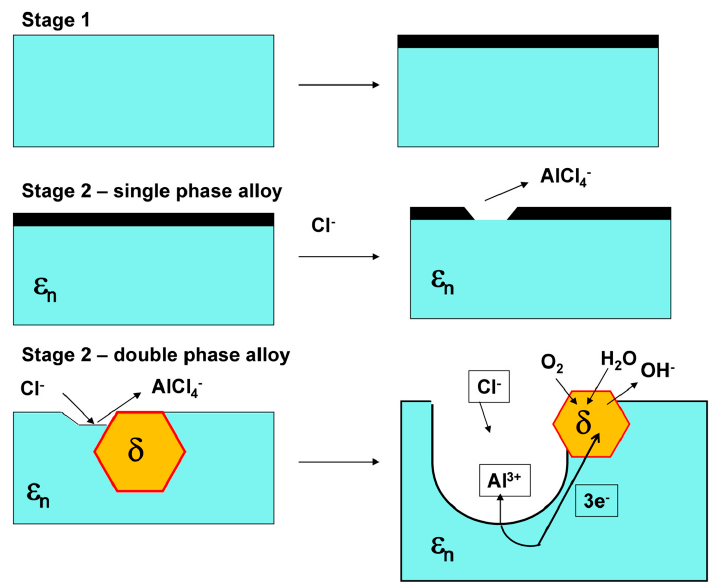
Figure 9. Pitting corrosion mechanism of the Al–Pd–Co alloys. For the color interpretation of this figure, the reader is referred to the web version of this article.